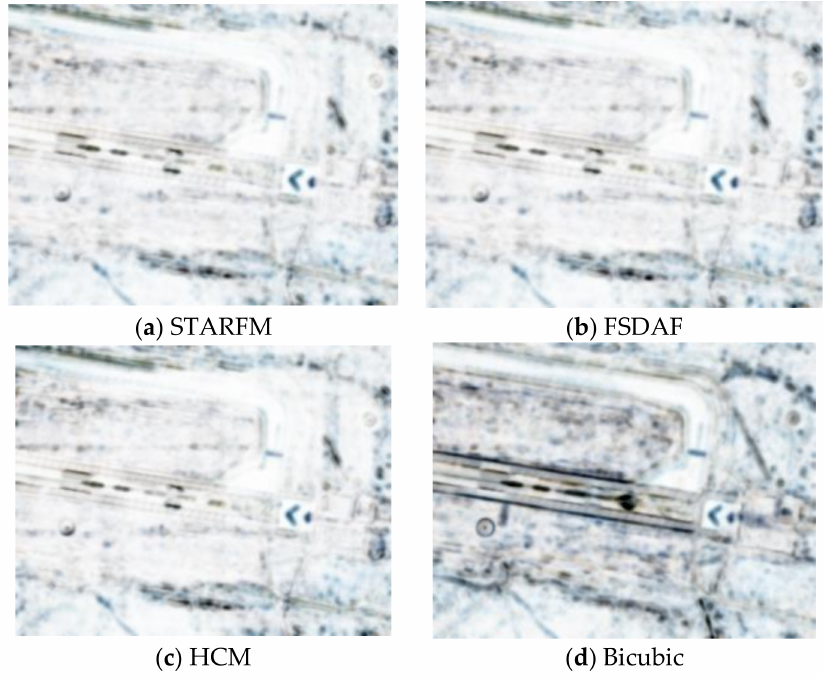
Figure 13. SSIM maps of the Runway scenario using different methods. ( a – d ) are the maps for STARFM, FSDAF, HCM, and bicubic,